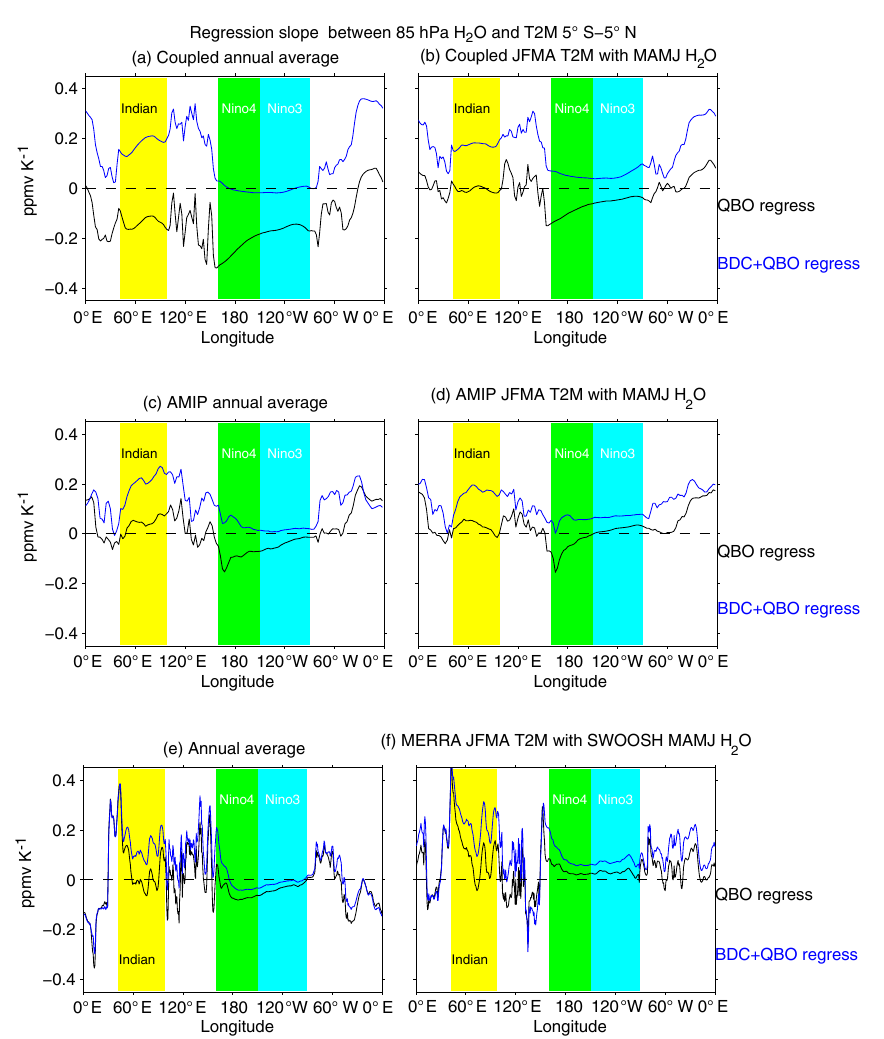
Figure 9. Regression coefficient between tropical (5 ◦ S and 5 ◦ N) 2m temperature (T2m) and zonally averaged entry water vapor at 85hPa in (a–b) the last 240 years of a coupled ocean–atmosphere run, (c–d) the AGCM runs, and (e–f) for SWOOSH water vapor and MERRA 2m temperatures. The longitude bands corresponding to the Indian Ocean, Niño-3, and Niño-4 regions are in color. The left column is for annual averaged quantities and the right column is for March through June water vapor with T2m 2 months prior. We show resulting regression coefficients after first regressing out the effect of the QBO at 50hPa from the water vapor anomalies (black) and also after regressing out the effect of the QBO at 50hPa and the BDC from the water vapor anomalies